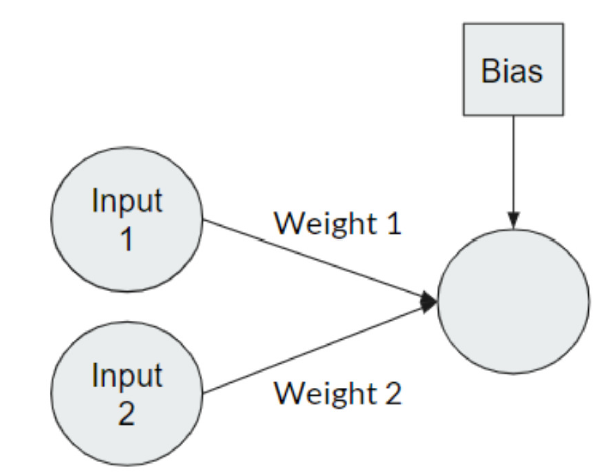
Figure 1. Bias value for each